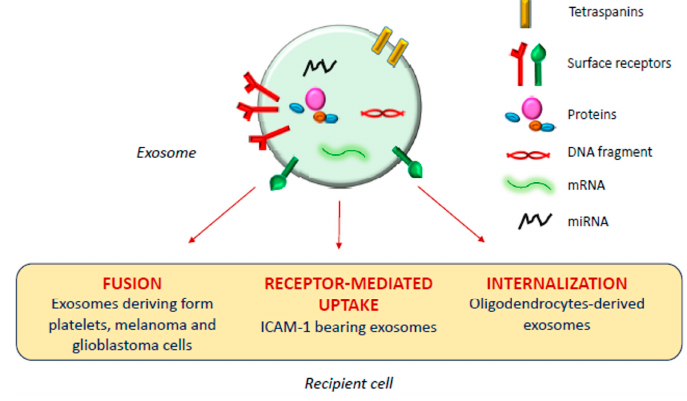
Figure 1. Exosomal mechanism of interaction with recipient cells.